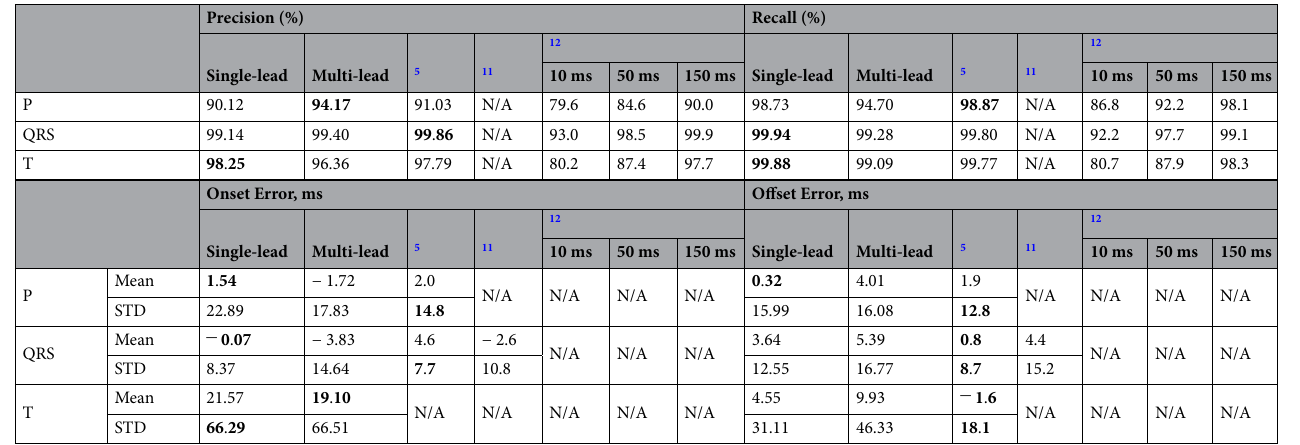
the multi-lead prediction strategy is the only metric that shows worse performance with respect to the inherent dataset bias (4.53 ± 42.71 ms vs. 4.55 ± 31.11 ms and 9.93 ± 46.33 ms), and is within 1 sample (4 ms) difference. Discussion Deep learning techniques show improved performance upon classical approaches for supervised tasks given suf- ficient training data 27 . These models can be used to improve and automate tasks in the medical domain such as image (or signal) segmentation, aiding in clinical decision-making 28 . Moreover, these models can be re-trained on newly acquired data to produce a positive feedback loop that enhances performance upon usage.